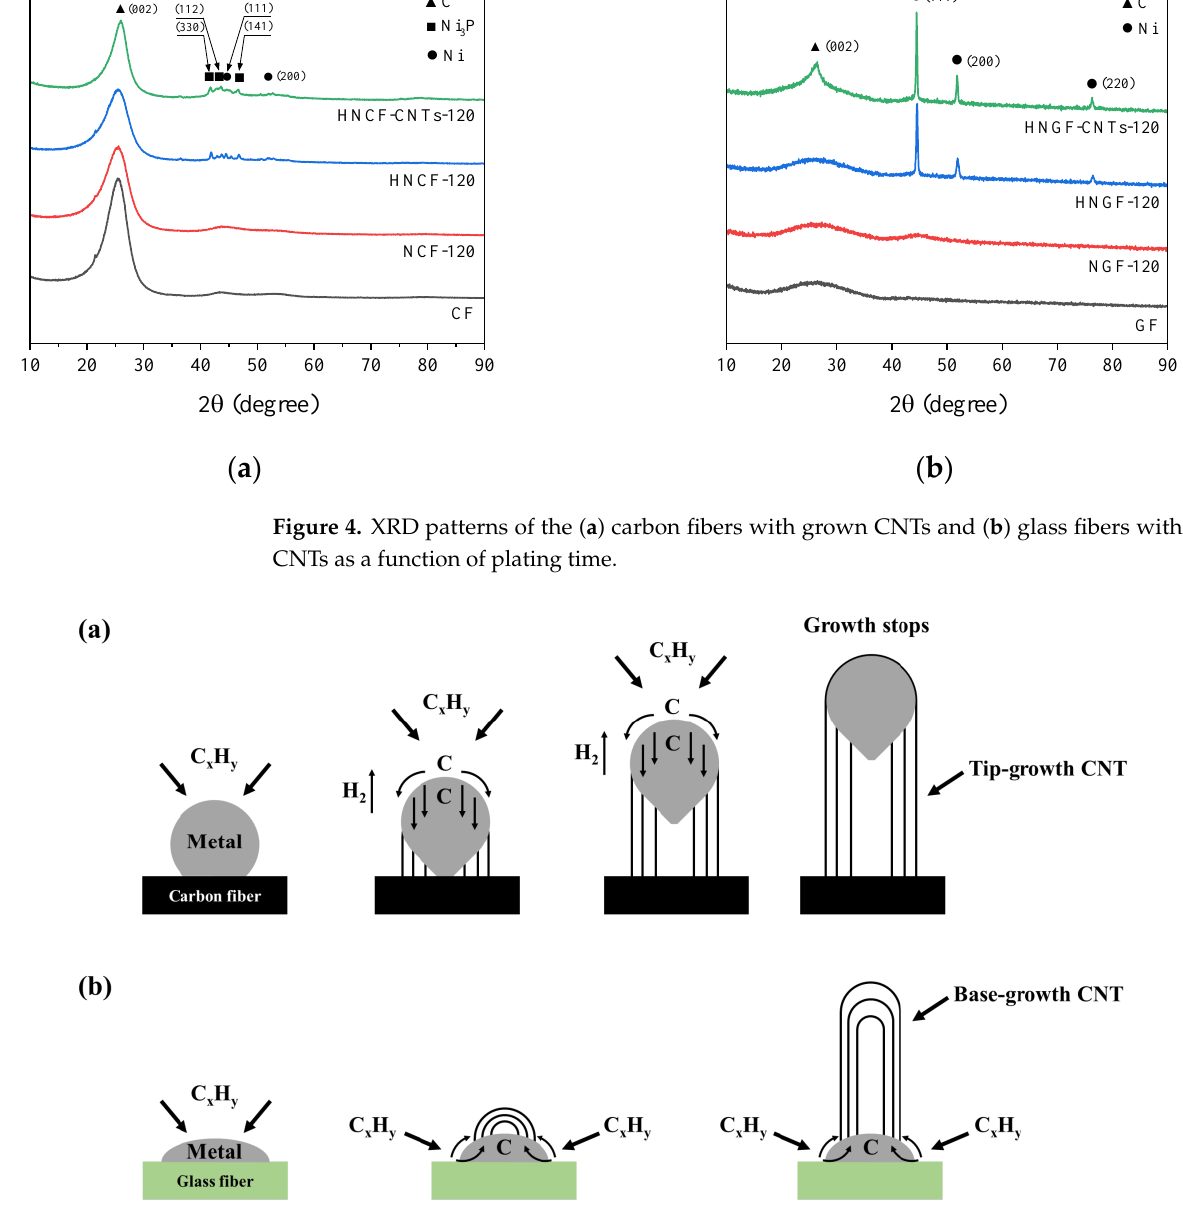
Figure 5. CNT growth mechanism: ( a ) tip-growth model and ( b ) base-growth model [49].